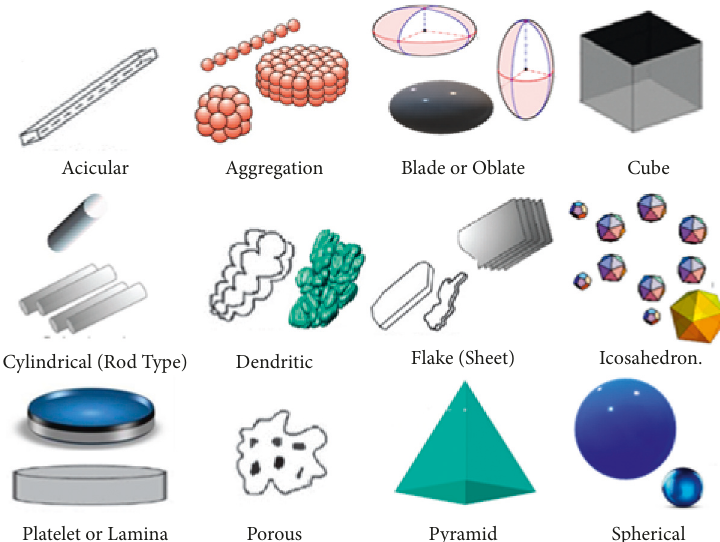
Figure 2: Some of the diverse particle shapes and geometries of nanoparticles.